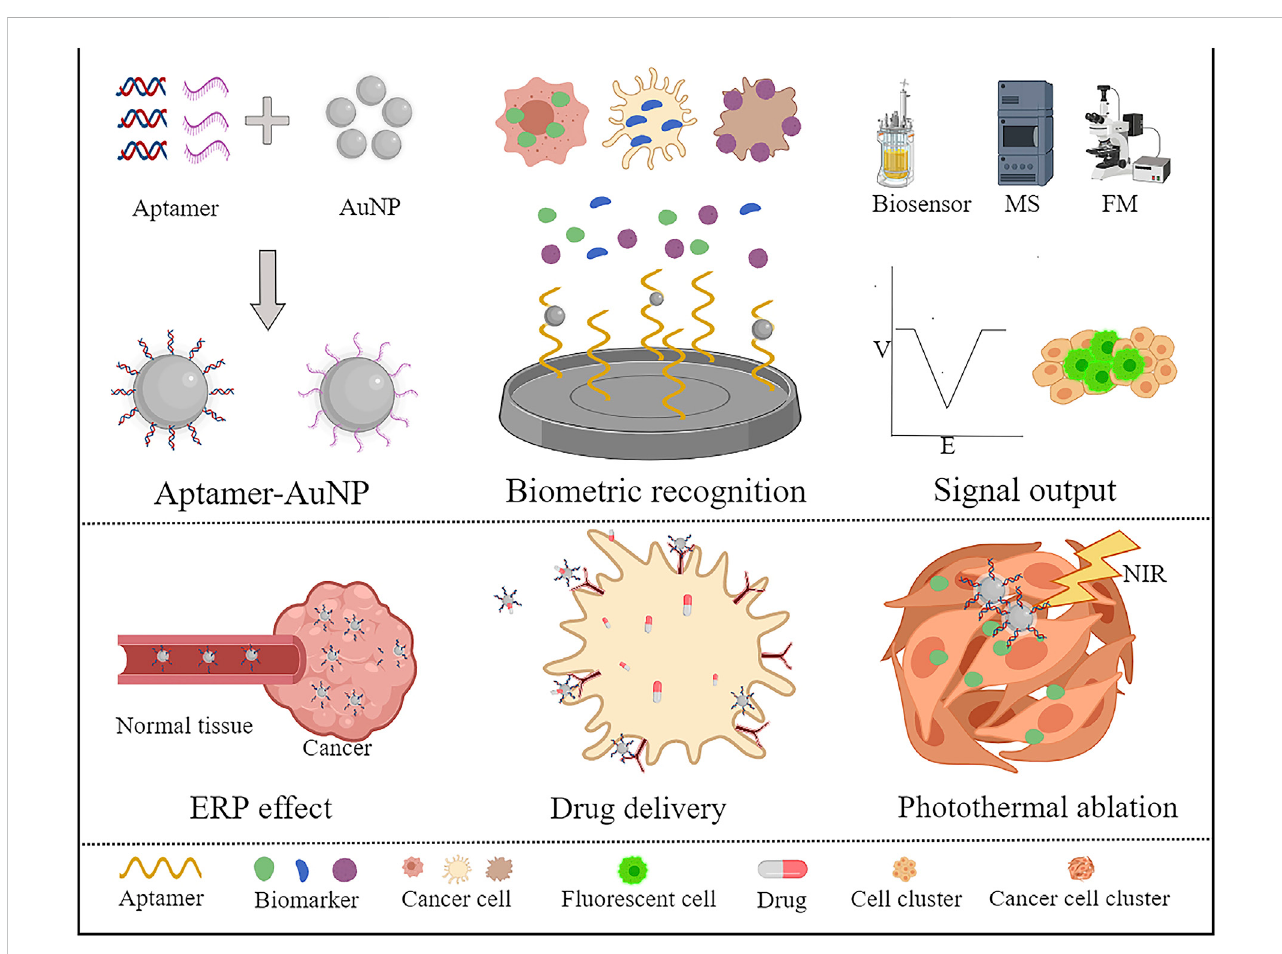
FIGURE 1 Application of aptamers combined with AuNPs for the diagnosis and treatment of tumours. A variety of special tumour markers have been developed based on AuNP binding with aptamers. The detection results can be visualized by combining biosensors, computed tomography, fl uorescence microscopes, etc. The researchers also targeted tumour therapy with drug carriers and photothermal therapy through AuNP junction suitable